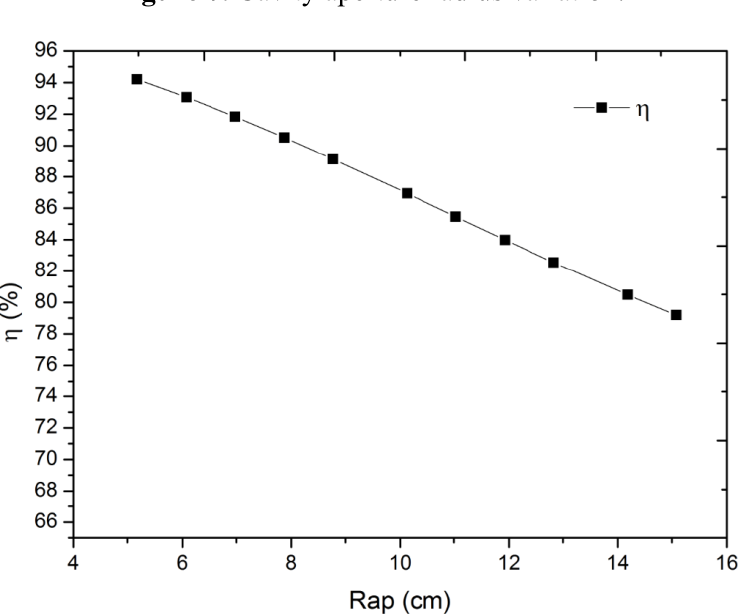
Figure 8. Efficiency against aperture radius (solar source: 28